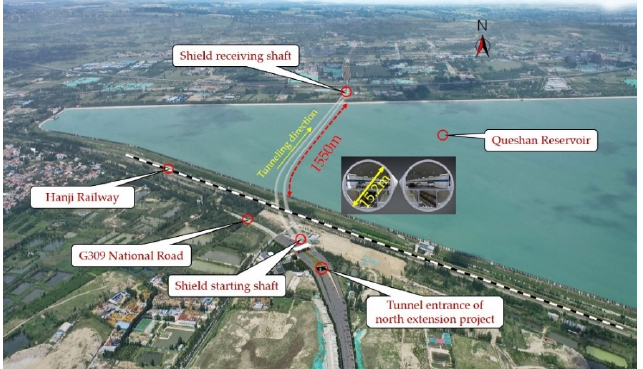
Figure 13. Plan view of the project.